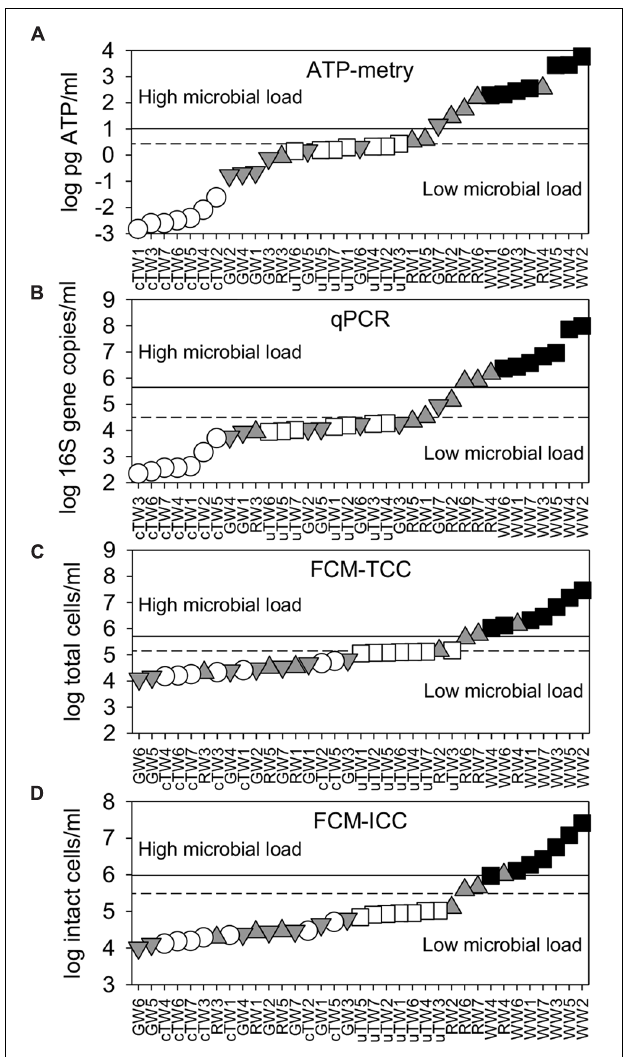
FIGURE 2 | Water microbial load as assessed by alternative parameters [i.e., (A) ATP content; (B) 16S rRNA gene abundance; (C) total cell counts, TCC; and (D) intact cell counts, ICC]. All data were plotted in ascending rank order on a logarithmic scale in order to better visualize warning (dashed lines) and alarm (solid lines) thresholds, which discriminate waters with low and high microbial load. Samples included chlorinated Tap Waters (cTW1-7), unchlorinated Tap Waters (uTW1-7), Ground Waters (GW1-7), Rivers Waters (RW1-7), and Waste Waters (WW1-7).